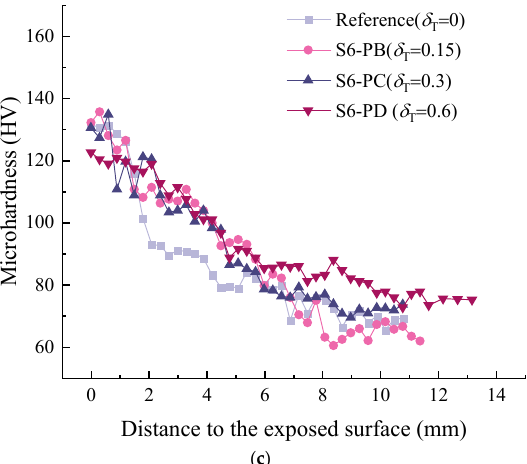
Figure 11. Change in microhardness along the profile perpendicular to the exposed surface after a certain carbonation period: ( a ) 7 d; ( b ) 14 d; ( c ) 28 d.